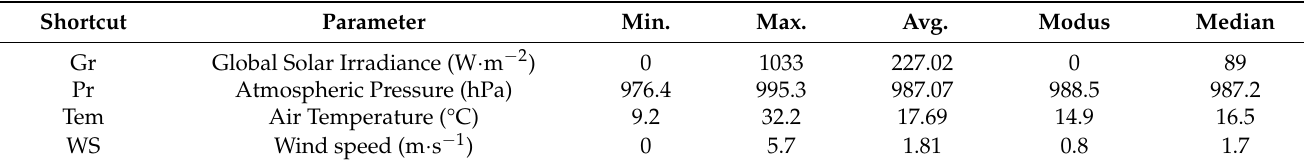
Table 4. Weather dataset values.